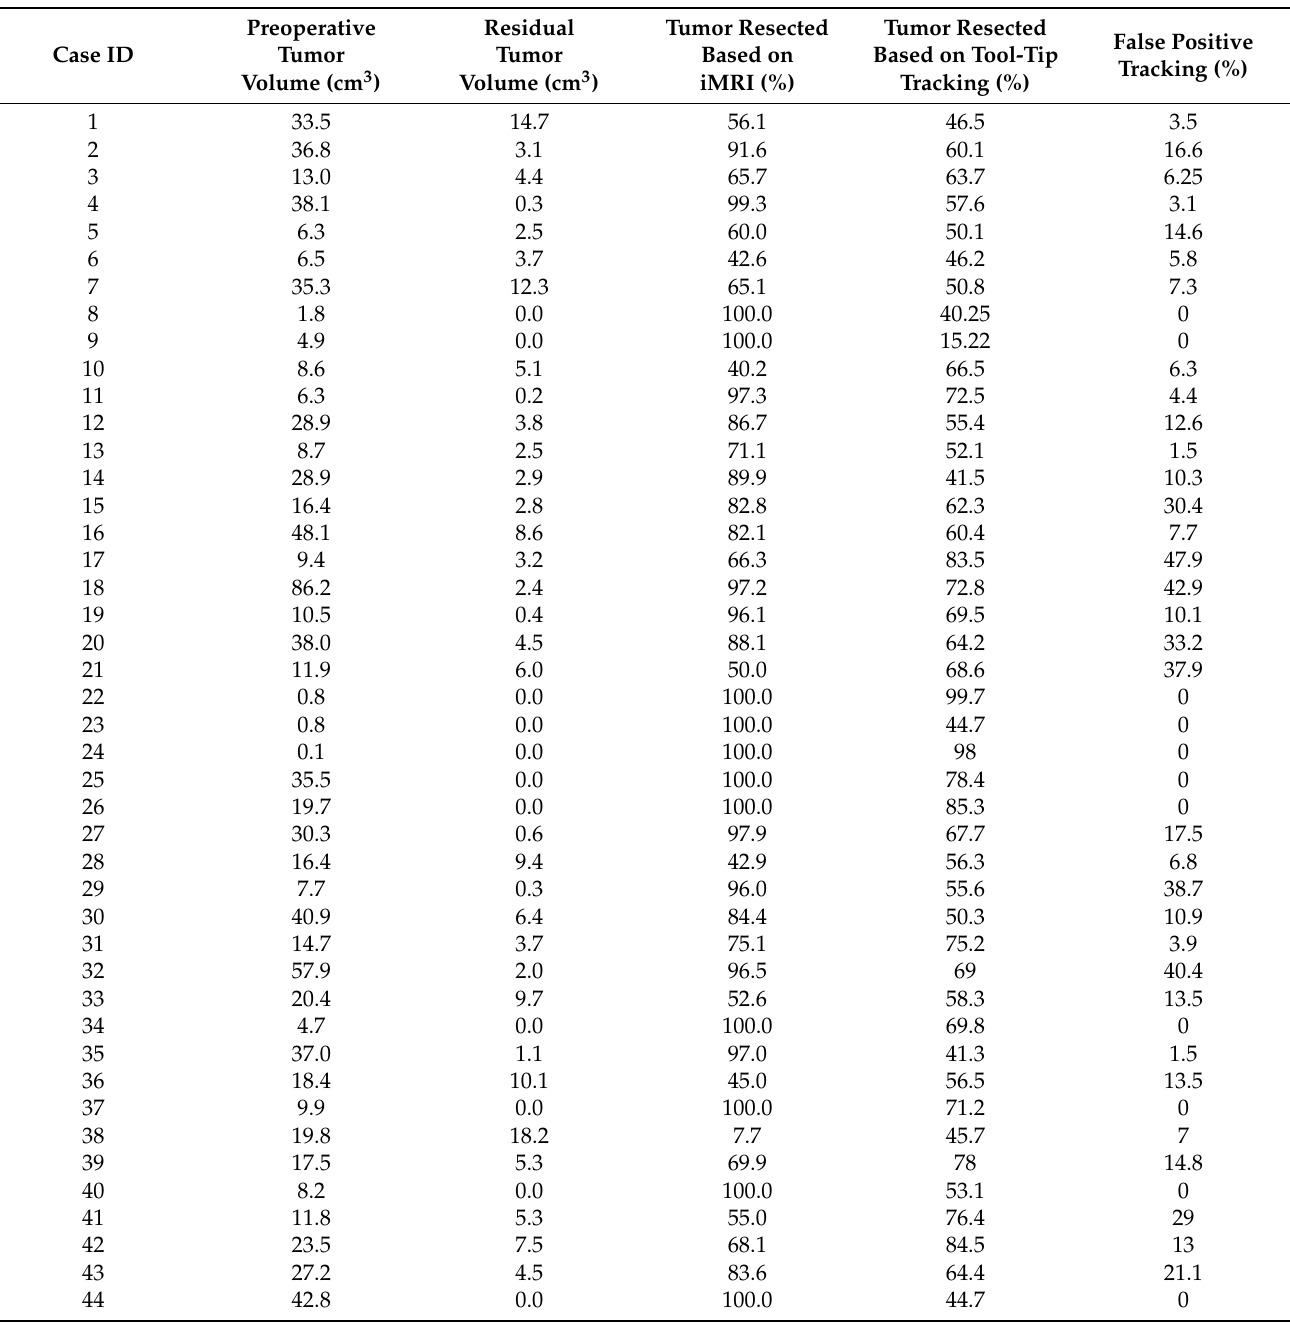
Table A1. Measurements of the volume of the lesion from preoperative MRI, the volume of the residual tumor from iMRI, the % of the lesion resected at the time of iMRI, the % of the lesion covered by the tracked resection cavity (True Positive Tracking), and the % of the residual covered by the tracked resection cavity (False Positive